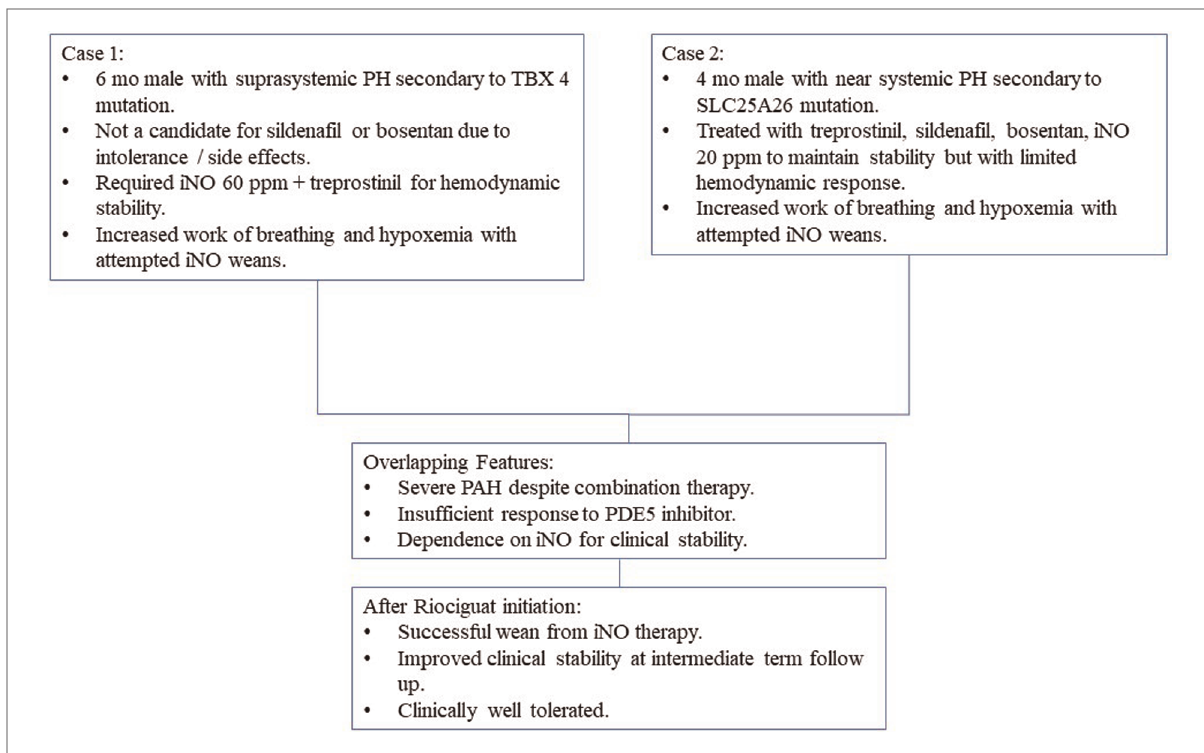
FIGURE 3 Summary of clinical